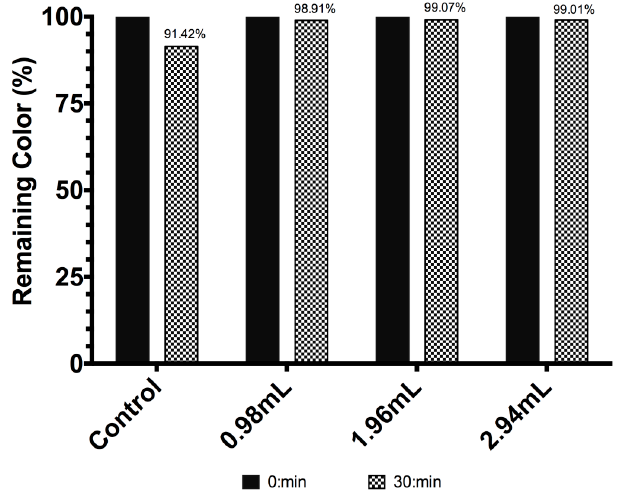
Figure 1. Betacyanin concentration (remaining color percent) for Beta vulgaris (Control) and modified Beta vulgaris , exposed to UV-light